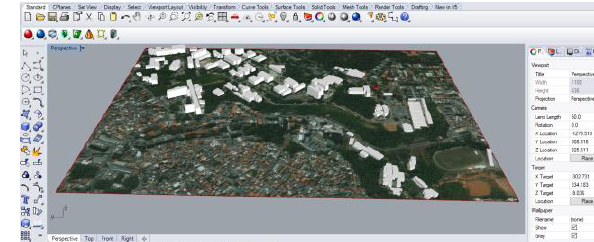
Figure 13: Visualization of the Rhinoceros geometric model done with the Heron